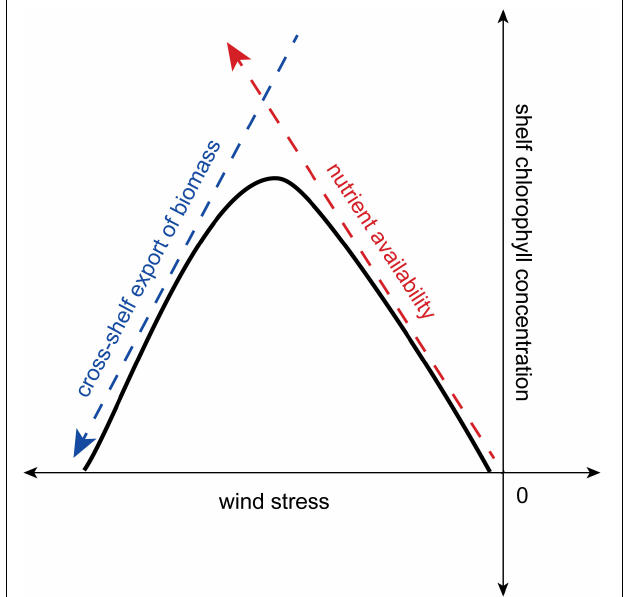
FIGURE 1 | A conceptual diagram representing the Botsford et al. (2003) relationship. The relationship between shelf chlorophyll concentration and upwelling-favorable wind stress (black curve) results from the balance between the chlorophyll response to nutrient availability (red dashed arrow) and the chlorophyll response to cross-shelf export of biomass (blue dashed